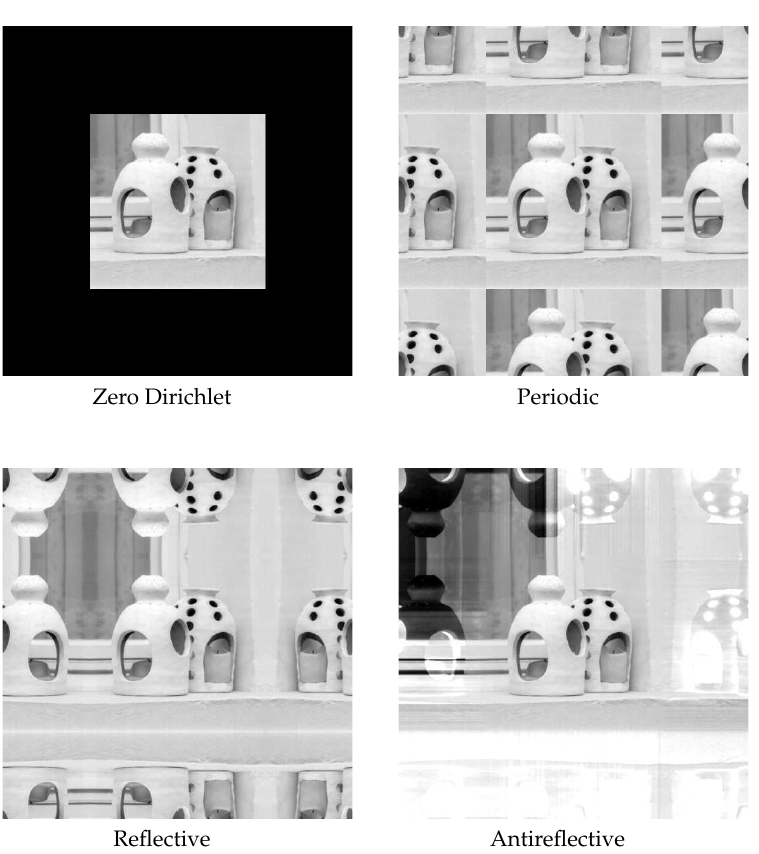
Figure 2. Examples of boundary